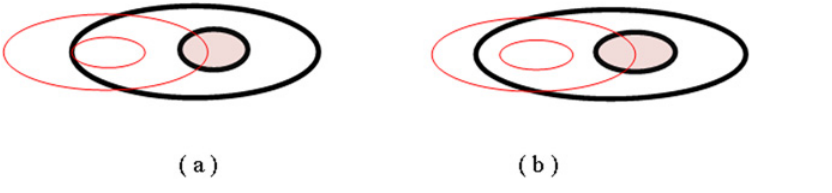
Fig 5. Two different topological relations between A1 and A2